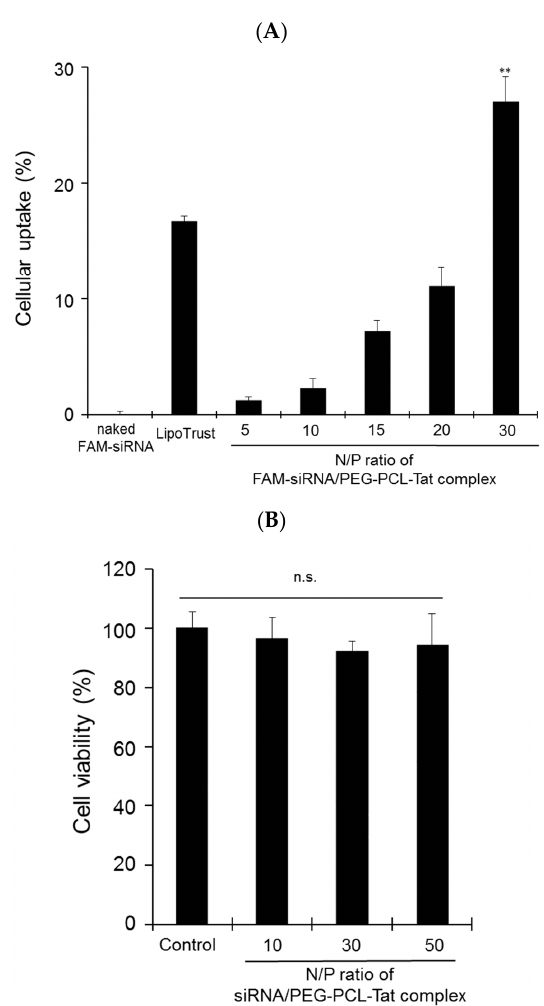
Figure 2. Cellular uptake of siRNA and cytotoxicity by PEG-PCL-Tat micelles in rat RN33B neuronal cells. RN33B cells were transfected with naked FAM-siRNA (1 µg), FAM-siRNA (1 µg) complexed with PEG-PCL-Tat (N/P ratio: 5–30), or Lipotrust as positive control. ( A ) After incubation for 4 h, the cellular uptake (%) of FAM-siRNA into RN33B cells was determined by flow cytometry. ( B ) Adapted with permission from [26]. Copyright 2019 American Chemical Society. After incubation for 3 h, in vitro cytotoxicity by PEG-PCL-Tat was determined by WST-8 assay. Each bar represents the mean ± S.D. (